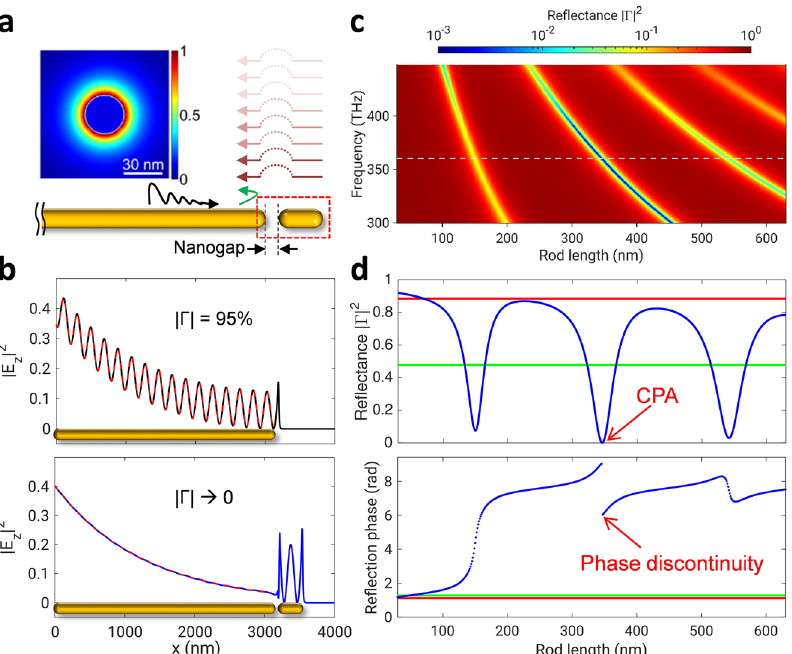
Figure 2: (a) Reflection of the right propagating guided plasmonic mode (black arrow) at the termination of a gold nanowire. The total mode reflection at the wire termination (red dashed rectangle) is determined by the interference between the directly reflected mode at the gap (green arrow) and a series of coherent transmissions from the mode oscillating on the nanorod (dark red arrows). See Section II of Supplementary Material for details. Inset: modal pro fi le of the guided wire mode. (b) Simulated standing wave patterns of the guided wire mode (electricnear- fi eldintensity) fora termination opento vacuum(upperpanel) andfacinga 346-nmnanorod(lower panel)via a 5-nmgap. The red dashed lines show the fi ts of Eq. (4) to these standing wave patterns (FDTD) using the complex re fl ectivity Γ as the only free fi t parameter. (c) Calculated re fl ectance ( | Γ | 2 ) as a function of the nanorod length and frequency. The gap is 4 nm. (d) Re fl ection intensity (upper panel) and phase (lower panel) as a function of the nanorod length at 360 THz, marked by the white dashed line in (c). The red and green horizontal lines mark the re fl ectance and phase of a termination open to vacuum and a gap in an in fi nitely long wire,